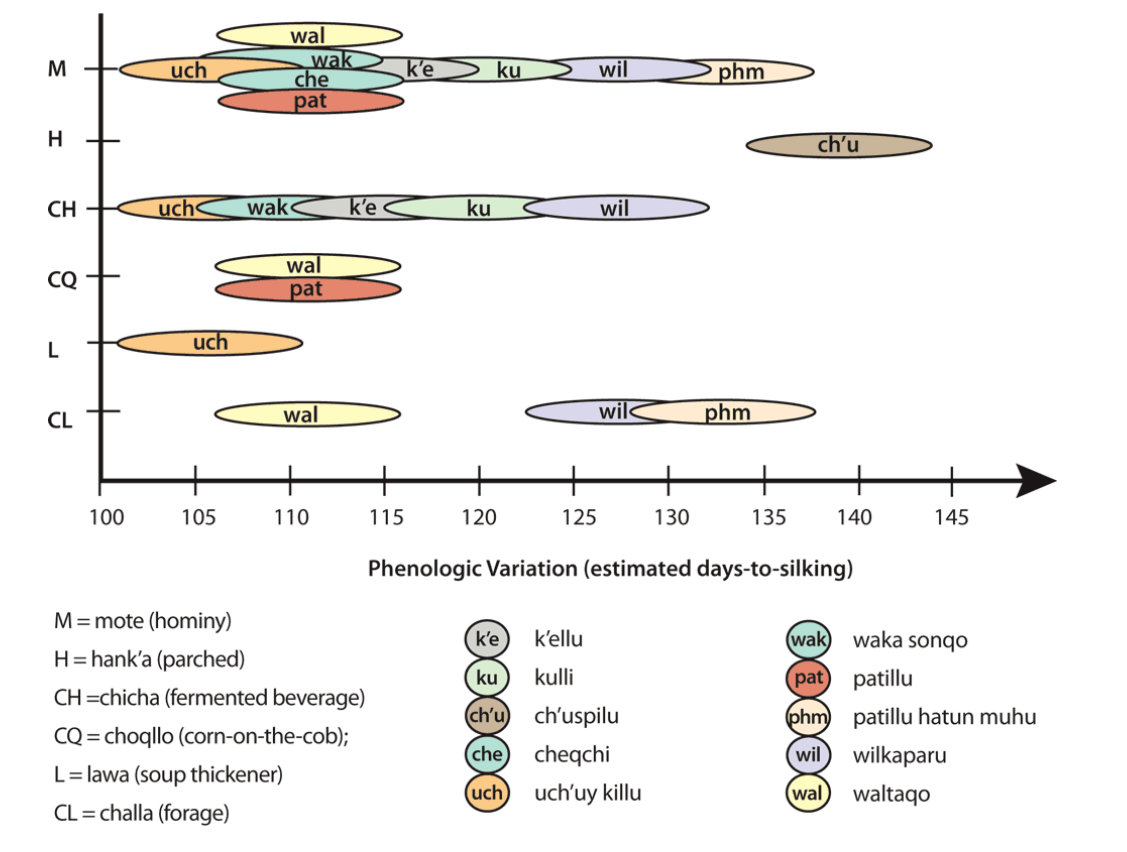
Fig. 4 . Diagram of the variation of maturation traits, i.e., phenology, and consumption uses of maize